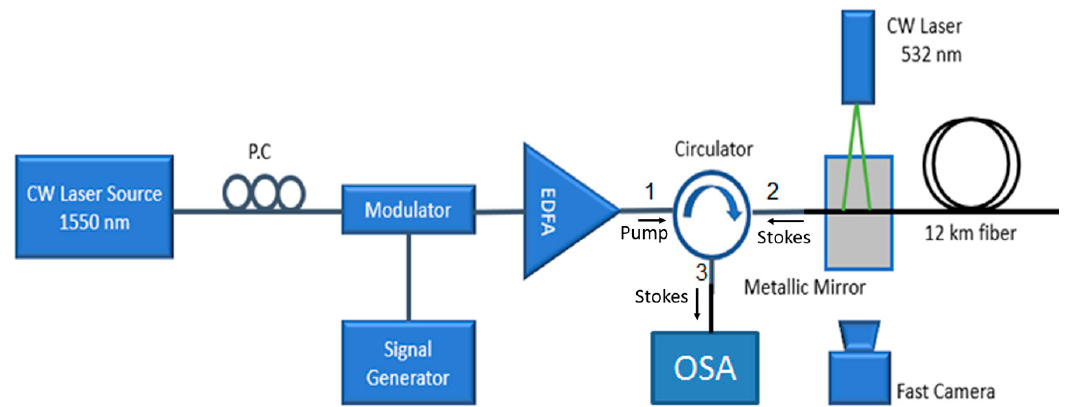
Figure 1. Schematic diagram of the experimental setup. PC: polarization controller; EDFA: Erbium doped fiber amplifier and OSA: optical spectrum analyzer.